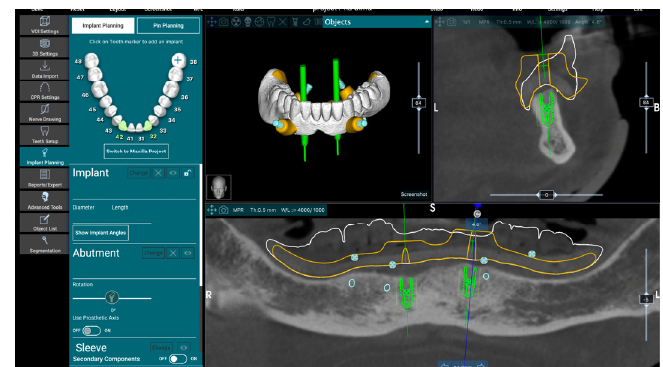
Figure 4. Virtual implant planning for two-implant-retained, mandibular overdenture.